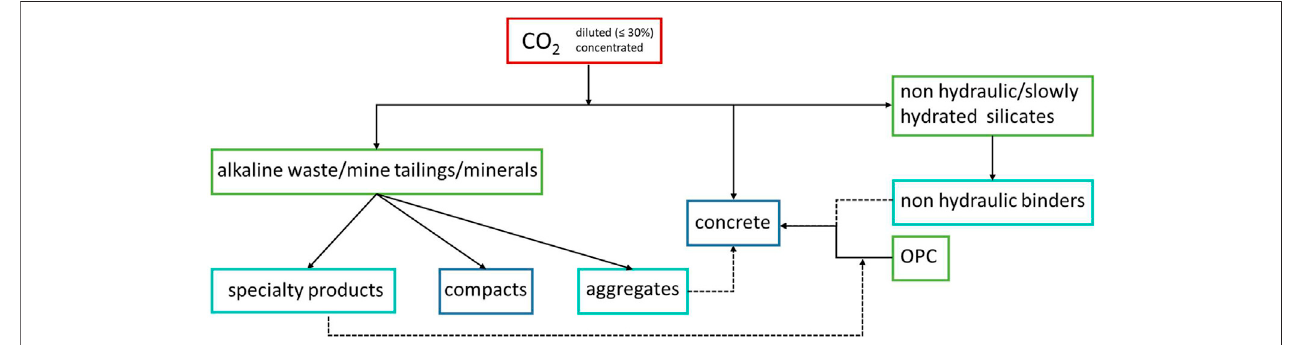
FIGURE 1 | Scheme of current CO 2 utilization pathways for producing carbonated materials to use in construction or other applications. Solid reagents are reported in green boxes, whereas fi nal products in blue. Turquois boxes highlight MC products that can be used as reagents to manufacture other products.